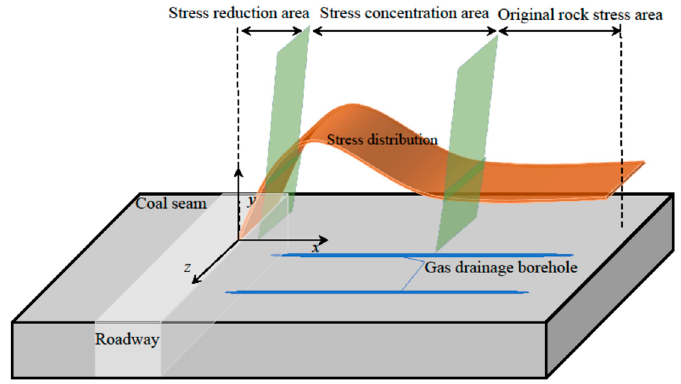
Figure 2. Three-dimensional spatial structure of gas drainage borehole and roadway crossing.